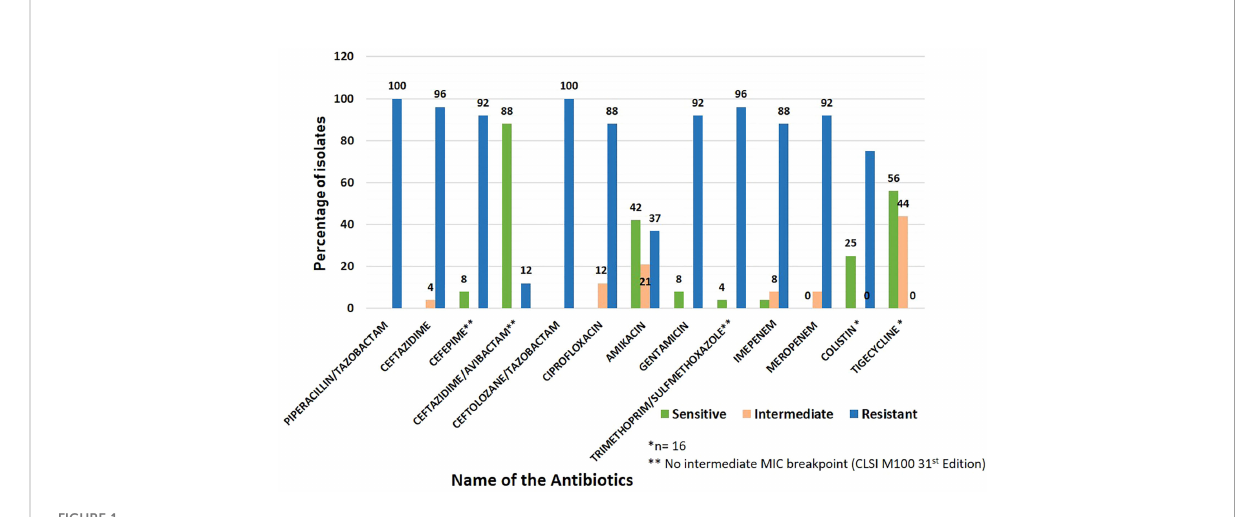
FIGURE 1 Antibiotic susceptibility pattern in carbapenem-resistant Klebsiella pneumoniae (CRKP) clinical isolates included in the